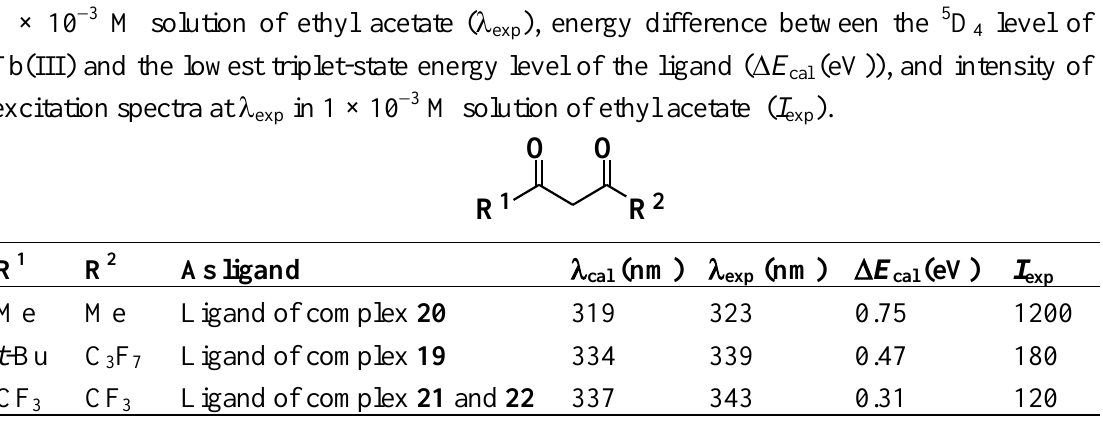
Table 4. The calculated maximum wavelength (  1 × 10  3 M solution of ethyl acetate (  Tb(III) and the lowest triplet-state energy level of the ligand (  E